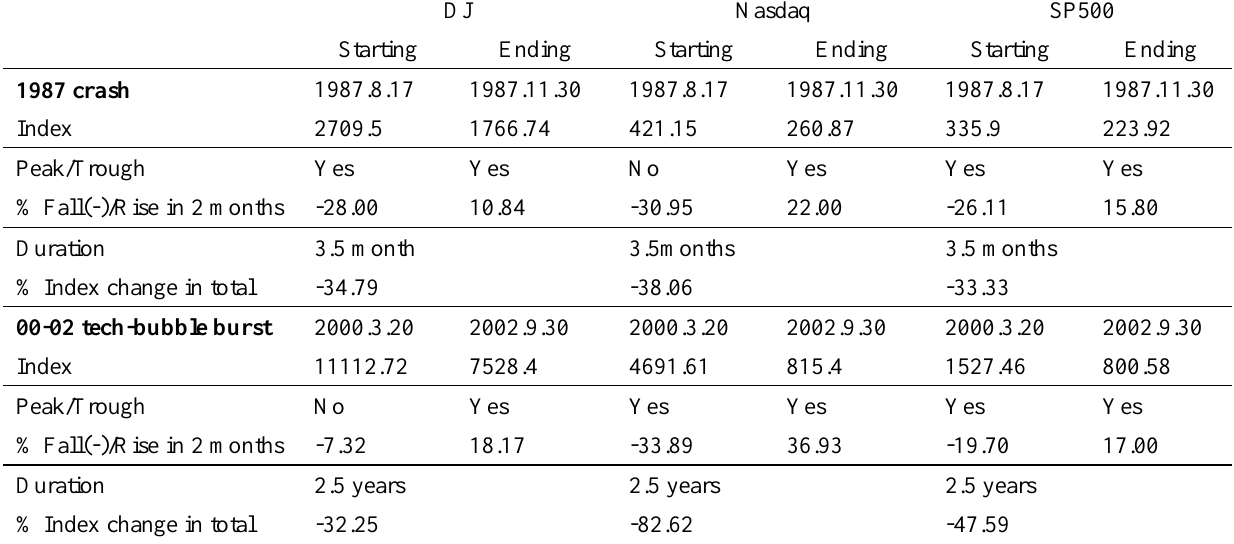
Table 2: Identification of stock market crashes from 1985 to